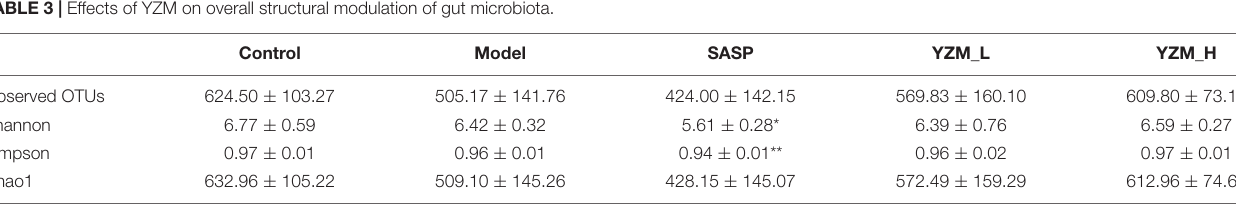
FIGURE 3 | SCFAs produced by intestinal microbiota. (A–F) Represents SCFAs amount as acetic acid, propionic acid, butyric acid, isobutyric acid, valeric acid, Isovaleric acid. ### p < 0.001 vs control, # p < 0.05 vs control; *** p < 0.001 vs model, ** p < 0.01 vs model, * p < 0.05 vs model. TABLE 3 | Effects of YZM on overall structural modulation of gut